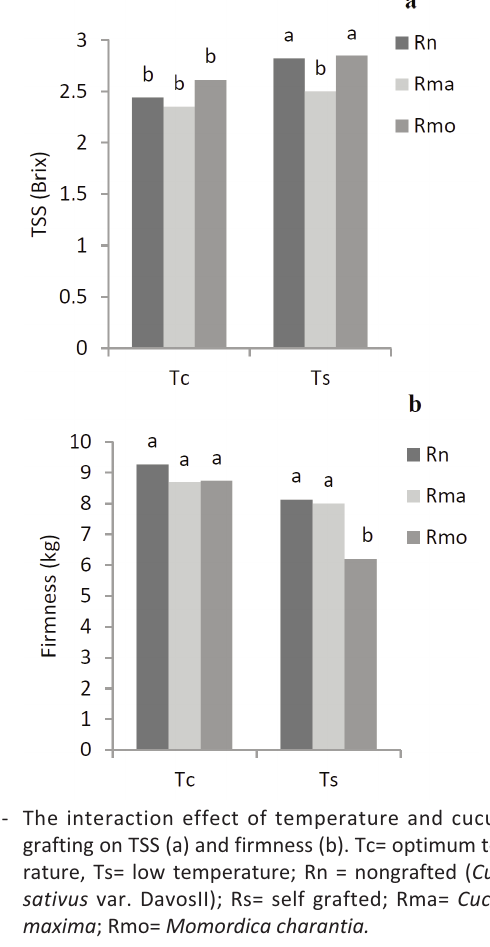
Fig. 8 ­ The interaction effect of temperature and cucumber grafting on photosynthesis (a), transpiration (b), stomata conductance (c), mesophyll conductance (d) Tc= opti­ mum temperature; Ts= low temperature; Rn = nongraf­ ted ( Cucumis sativus var. DavosII); Rs= self grafted; Rma= Cucurbita maxima ; Rmo= Momordica charantia